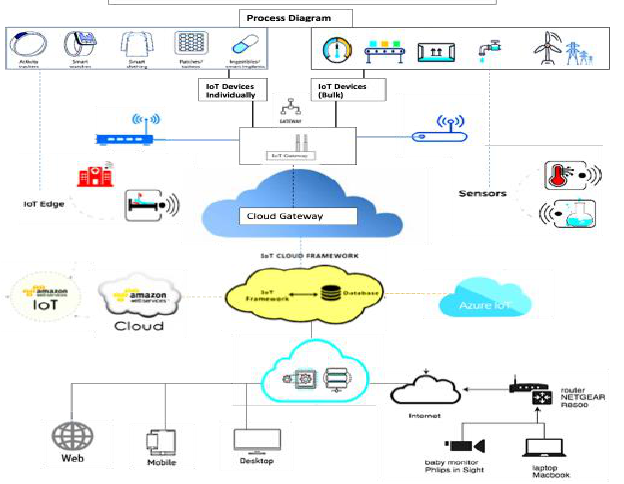
Figure 1 . IoT and Cloud integration